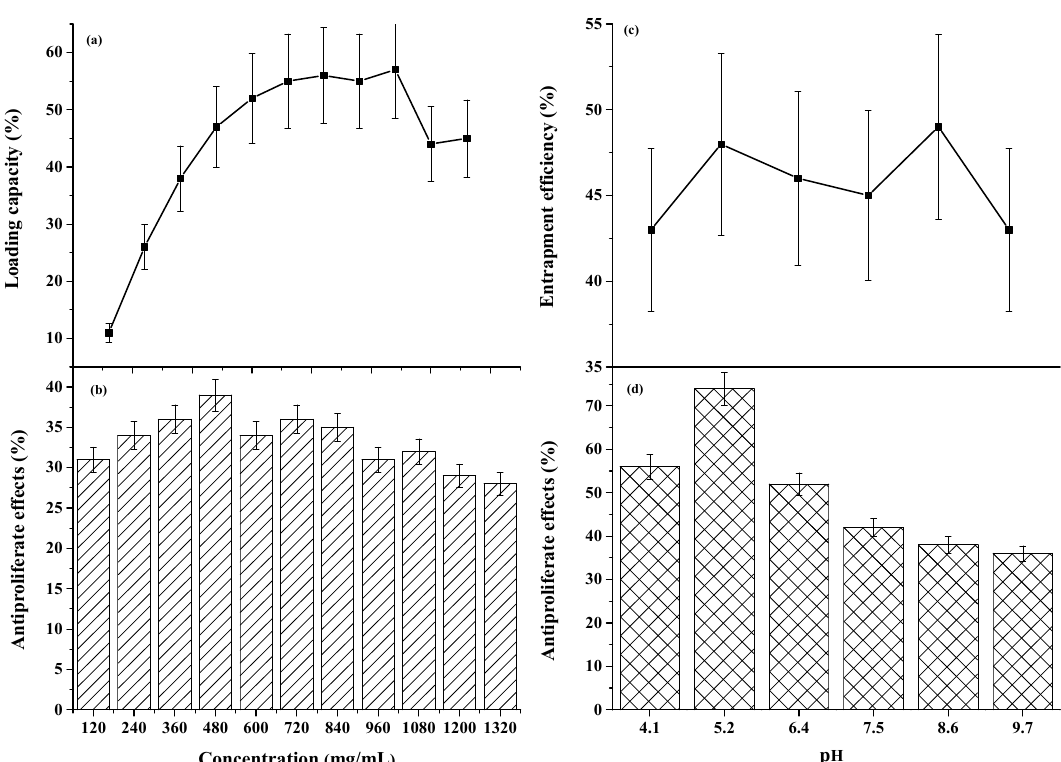
Figure 2. Optimization of the conditions for DR entrapment using HNTs. ( a ) The relative amount in percentage of entrapped bioactive compounds (mg/mL) using 5 grams bed volume of HNTs. The release was conducted for 2 days to ensure all the bound molecules were completely released from the lumen of the HNT. ( b )MTT assay for MCF-7 cell viability analysis of the entrapped bioactive compounds from the various crude extracts using 2 mg/mL. ( c ) The effects of buffer pH on the release of the immobilized bioactive compounds. ( d ) The relative activity of pH dependent bioactive compounds on MCF-7 cell viability using 2 mg/mL concentrations.